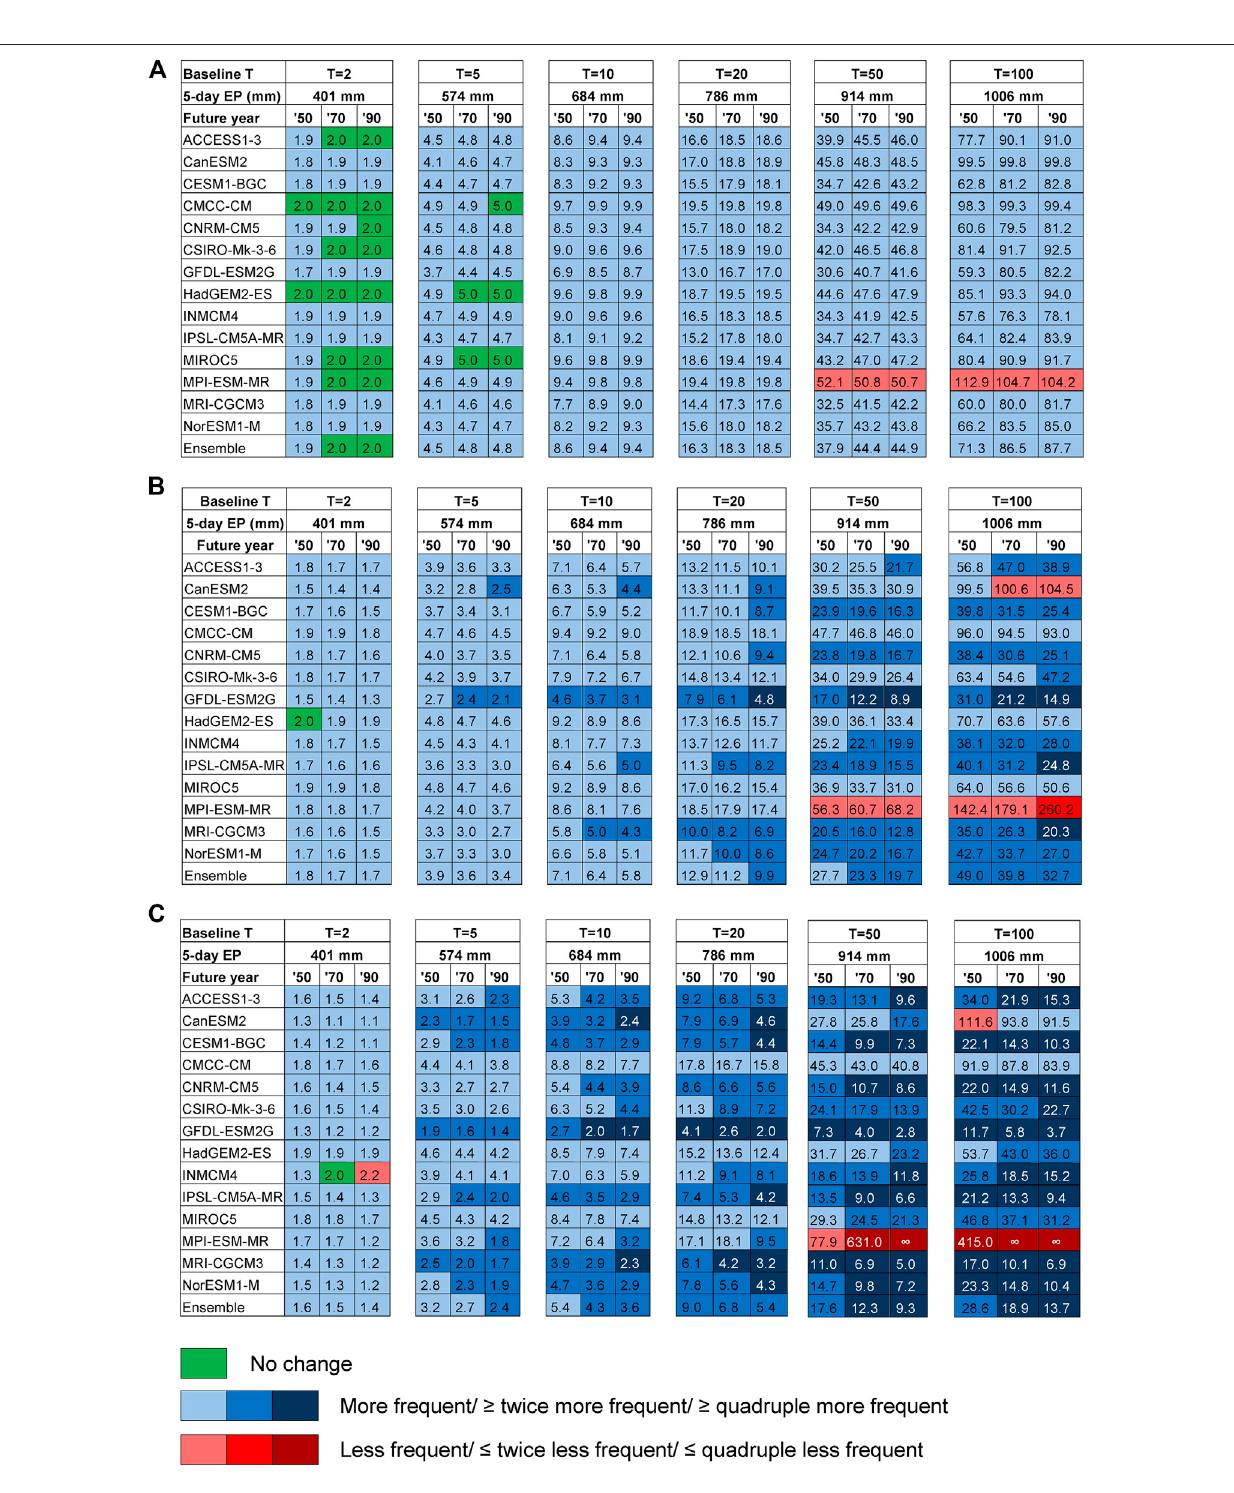
Frontiers in Earth Science |